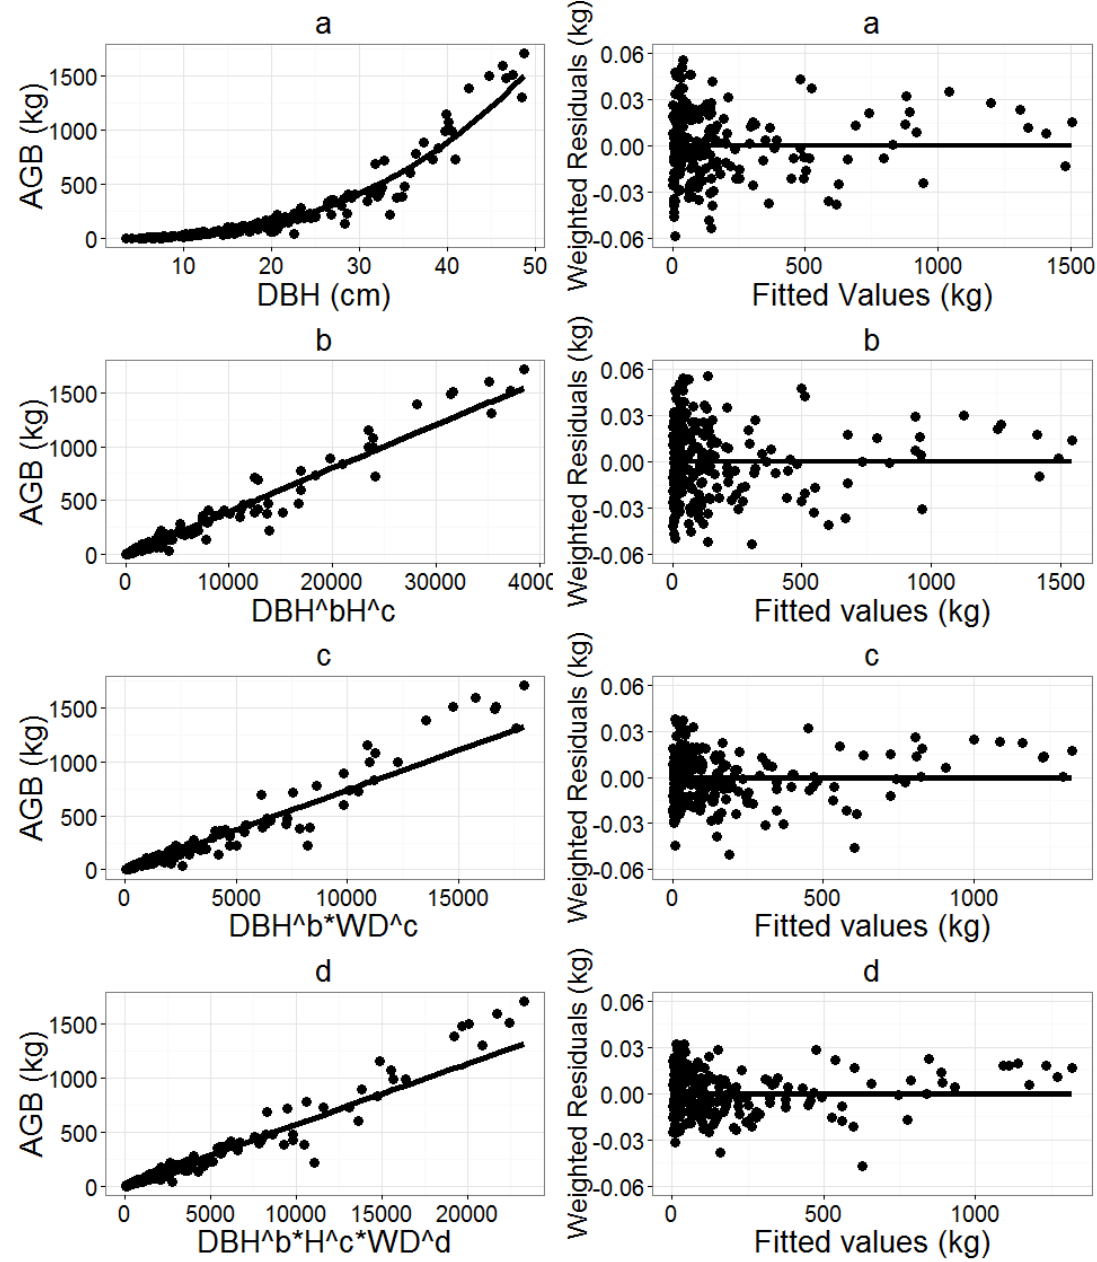
Figure 4. Plots of selected AGB models for mixed-species: fitted vs. observed (left column) and residuals vs. fitted (right column) using the entire dataset of 222 destructively sampled trees. ( a ) Model AGB = a × DBH b ; ( b ) Model AGB = a × DBH b × H c ; ( c ) Model AGB = a × DBH b × H c × WD d .